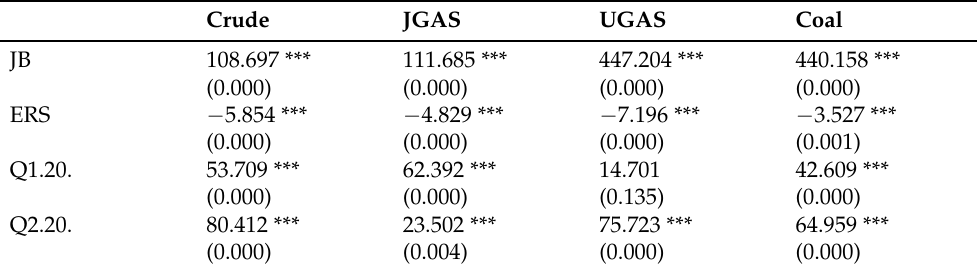
Figure 4. A graphical display of the scaled return series of energy asset return price series. Table 2. Statistical tests.